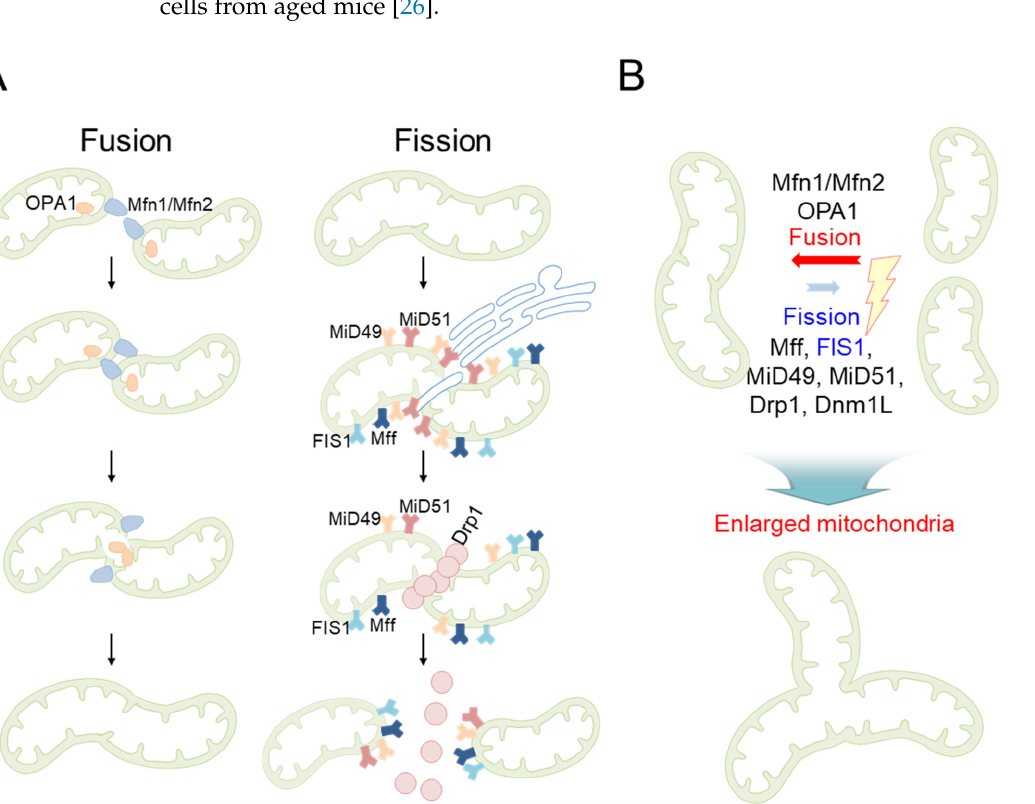
Figure 1. Mitochondrial alterations during the process of senescence and aging: ( A ) Mitochondria maintain their morphology, quality, and function through mitochondrial dynamics consisting of fusion and fission. Proteins involved in mitochondrial fusion: mitofusin 1 (Mfn1), mitofusin 2 (Mfn2), and OPA1. Proteins involved in mitochondrial fission: mitochondrial dynamics protein of 49 kDa and 51 kDa (MiD49 and MiD51, respectively), mitochondrial fission factor (Mff), mitochondrial fission 1 protein (FIS1), and dynamin-related protein 1 (Drp1). ( B ) Senescent and H 2 O 2 -induced senescent cells express low levels of FIS1, forming large mitochondria with highly interconnected network structures. ROS: reactive oxygen species. The lightning bolt represents senescence-associated